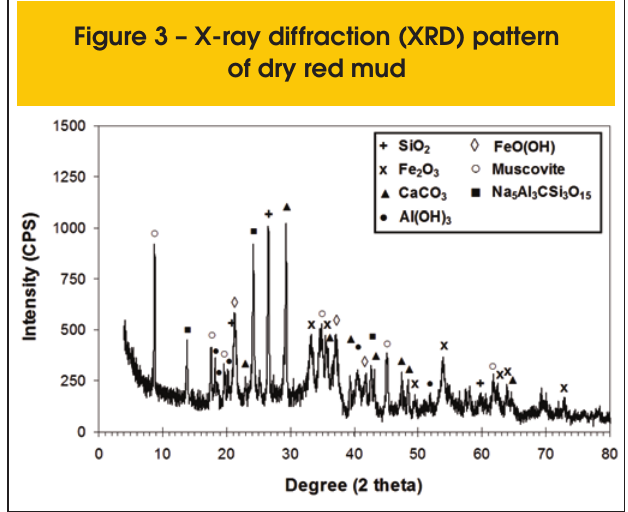
Figure 3 – X-ray diffraction (XRD) pattern of dry red